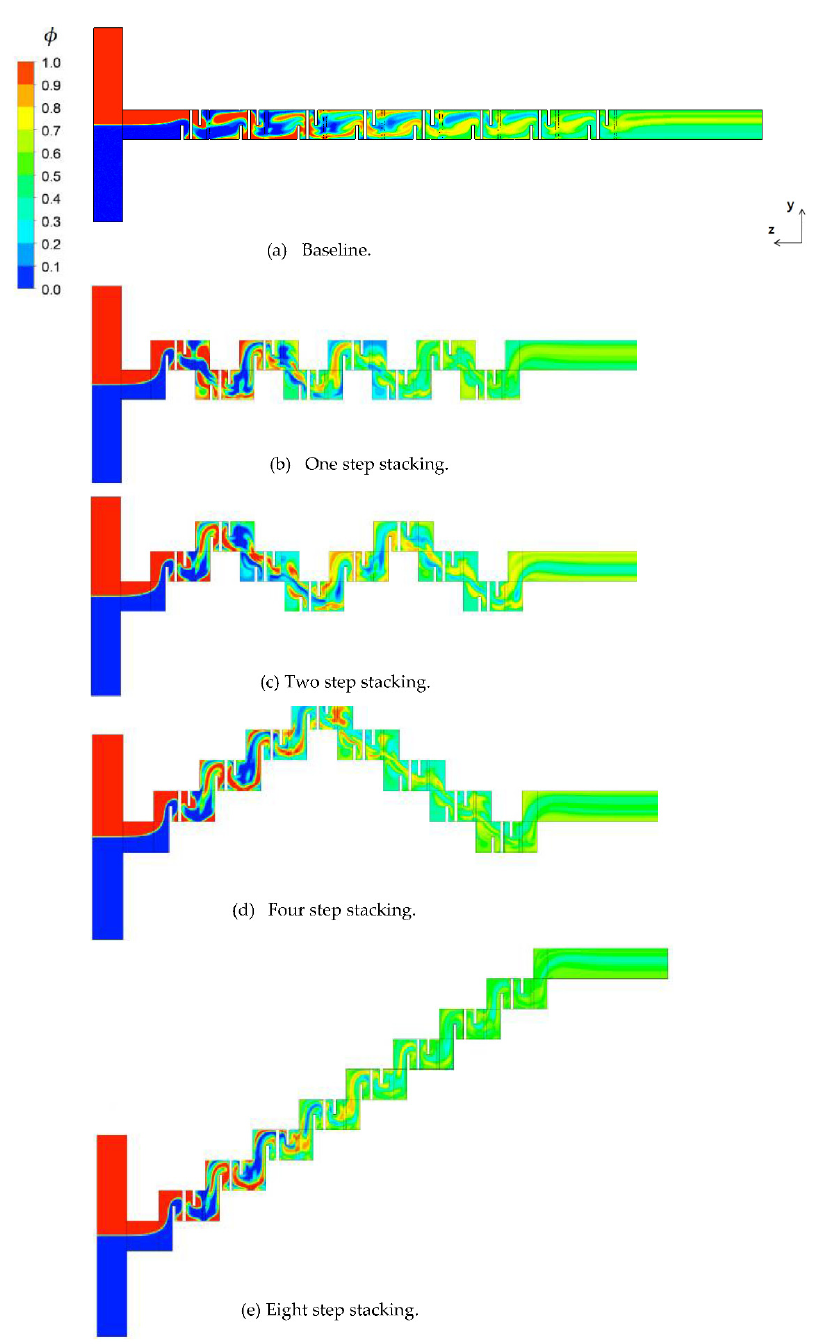
Figure 9. Concentration distribution for Re = 20 at the plane of half width z = 60 μ m.